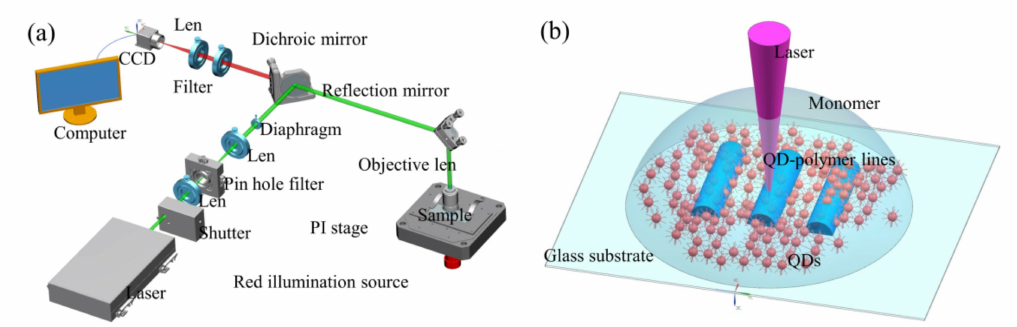
Figure 1. ( a ) Schematic diagram of the DLW apparatus and ( b ) the generation process of the QD–polymer